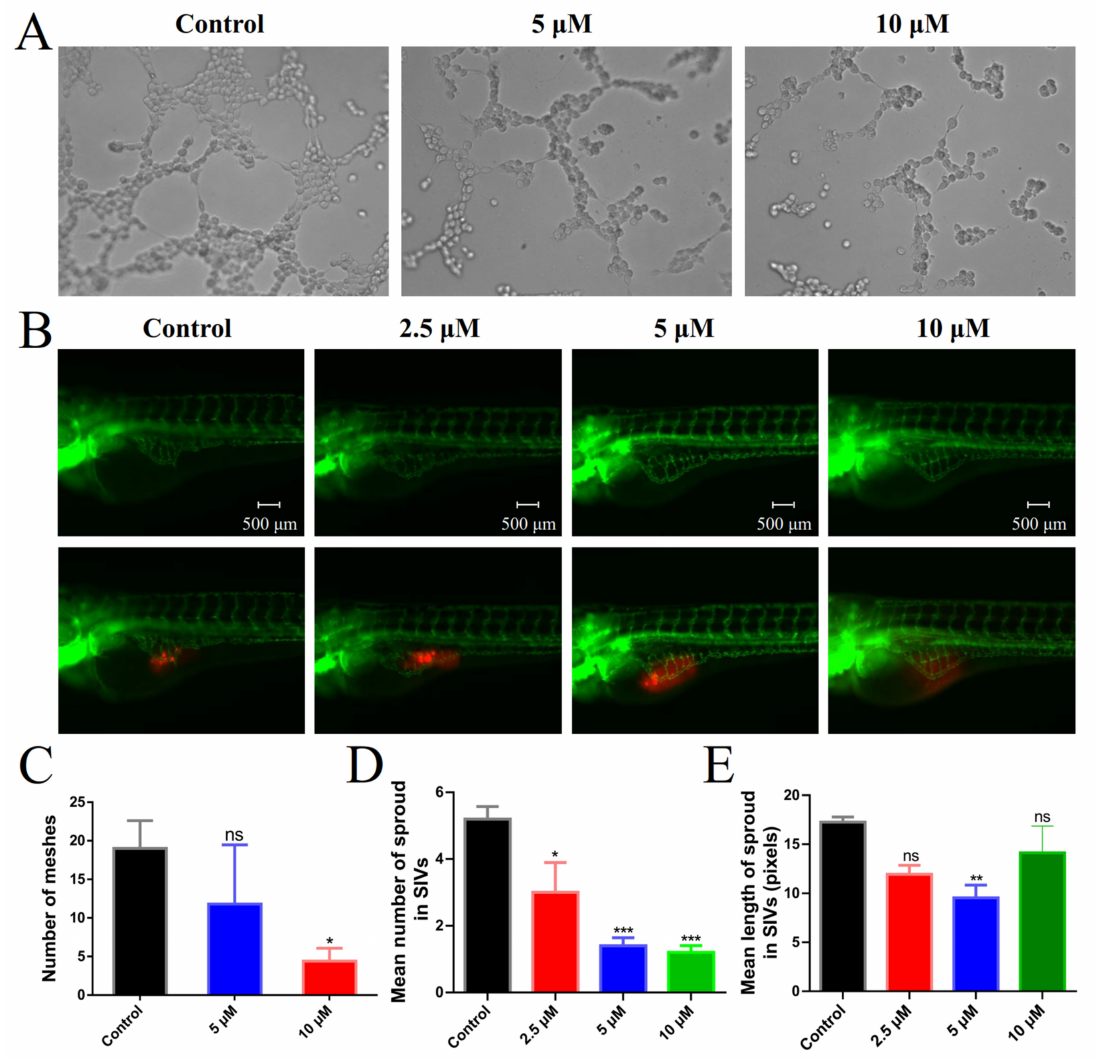
Figure 10. The angiogenesis formation inhibited by ∆ − 3 in vitro and in vivo. ( A ) In vitro inhibitory effect of ∆ − 3 on the tube formation of HUVECs cells with or without ∆ − 3 (0, 5, and 10 µ M) for 6 h at 37 ◦ C. The concentration of VEGF is 200 ng/mL. ( B ) Inhibition of angiogenesis in transgenic zebrafish (fil1:EGFP) treated with and without ∆ − 3 (0, 2.5, 5, and 10 µ M) for 24 h. ( C ) Number of meshes of the tube formation of HUVECs cells (n = 3/group).Data were plotted as means ± SD. Mean number ( D ) and mean length ( E ) of sprouts in SIVs after dealt without and with ∆ − 3 as 100% were quantified by manual counting at 72 hpf (n = 5/group). Statistical significance was assessed using one-way ANOVA. Values versus the control group: * p < 0.05; ** p < 0.01; *** p < 0.001. ns: not